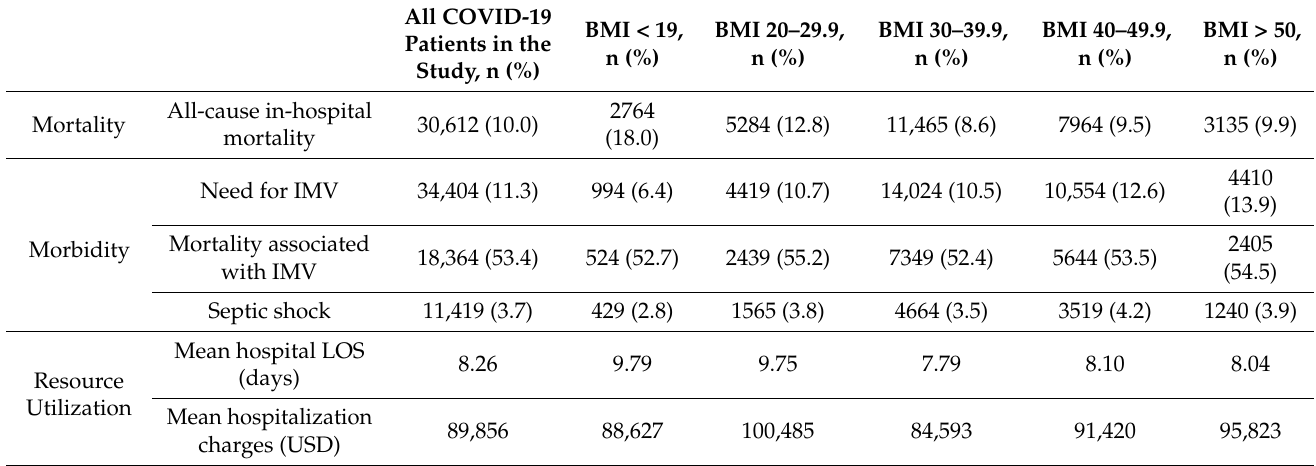
Table 2. Crude unadjusted outcomes of the